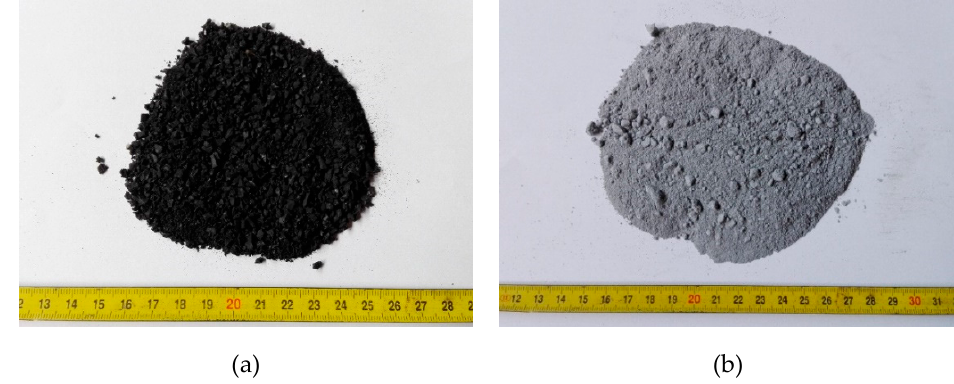
Figure 1. Test materials: ( a ) crumb rubber, ( b ) silica fume.